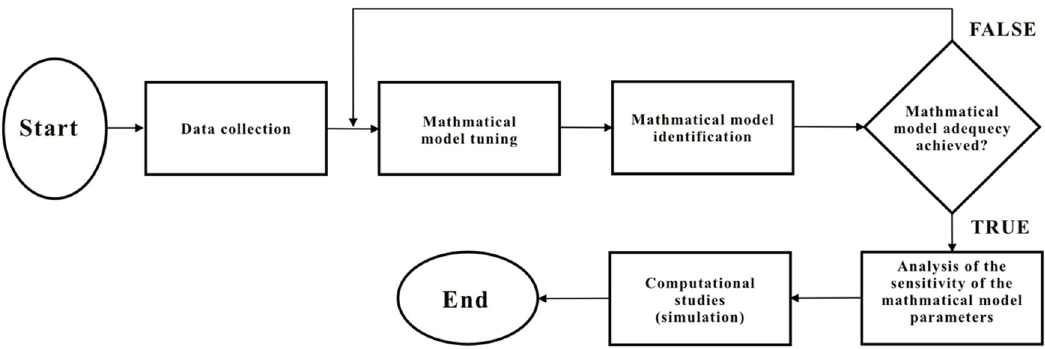
Figure 4. Study Figure 4. Study methodology.